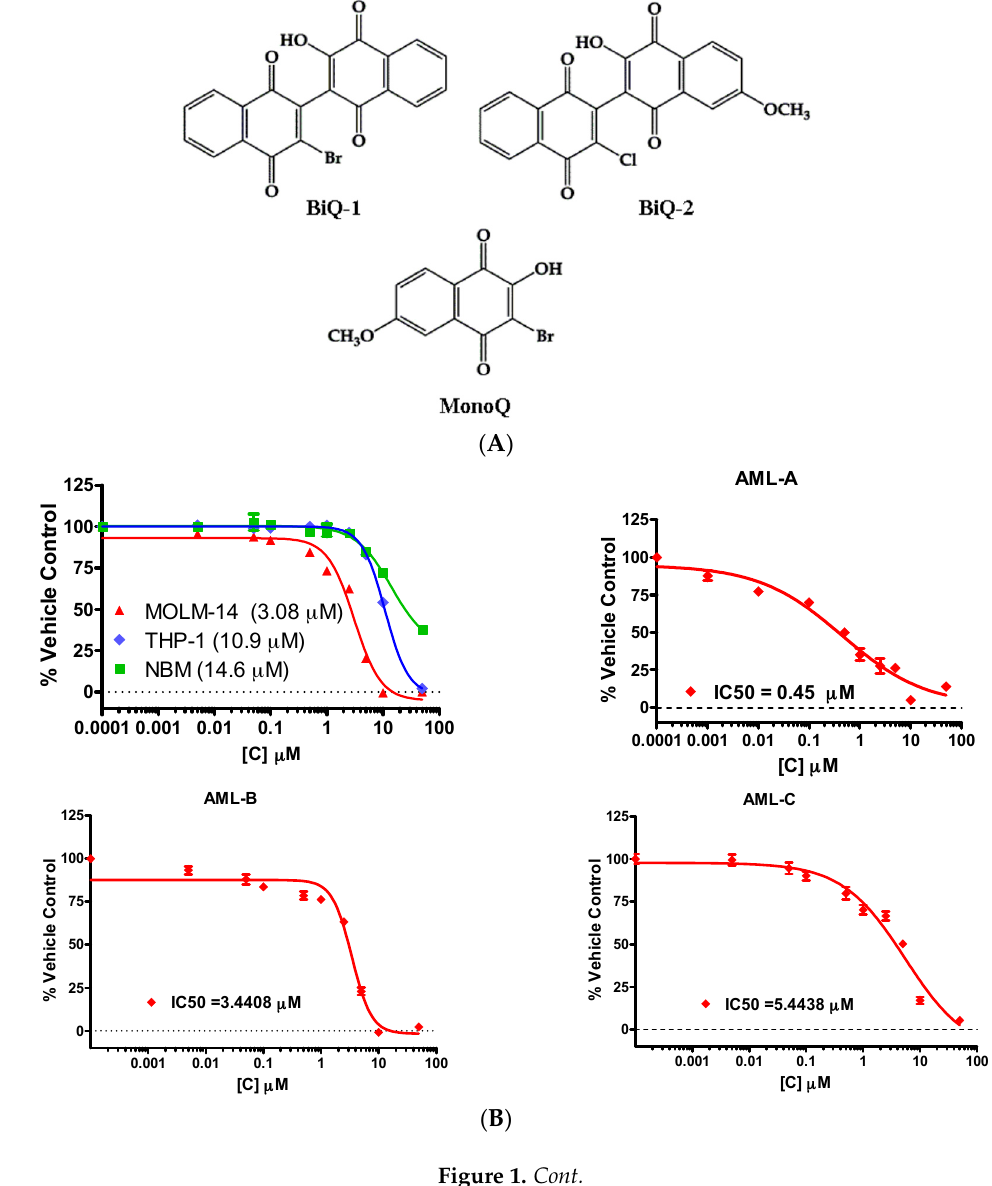
Figure 1. Cont. Figure 1.